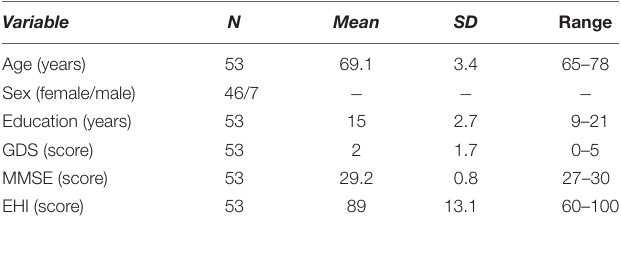
TABLE 1 | The characteristics of the subjects sample.